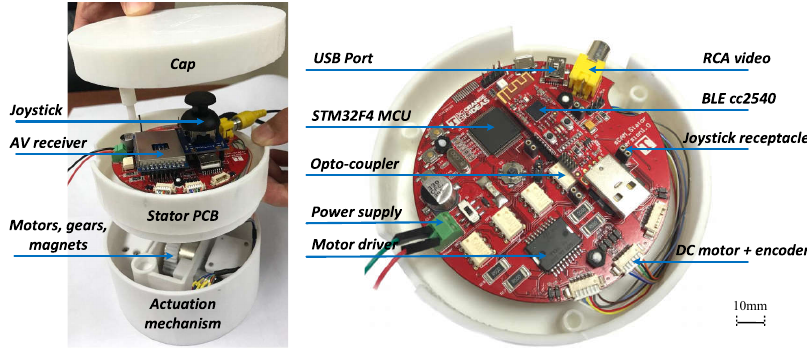
Figure 8. Implementation of the actuator electronic